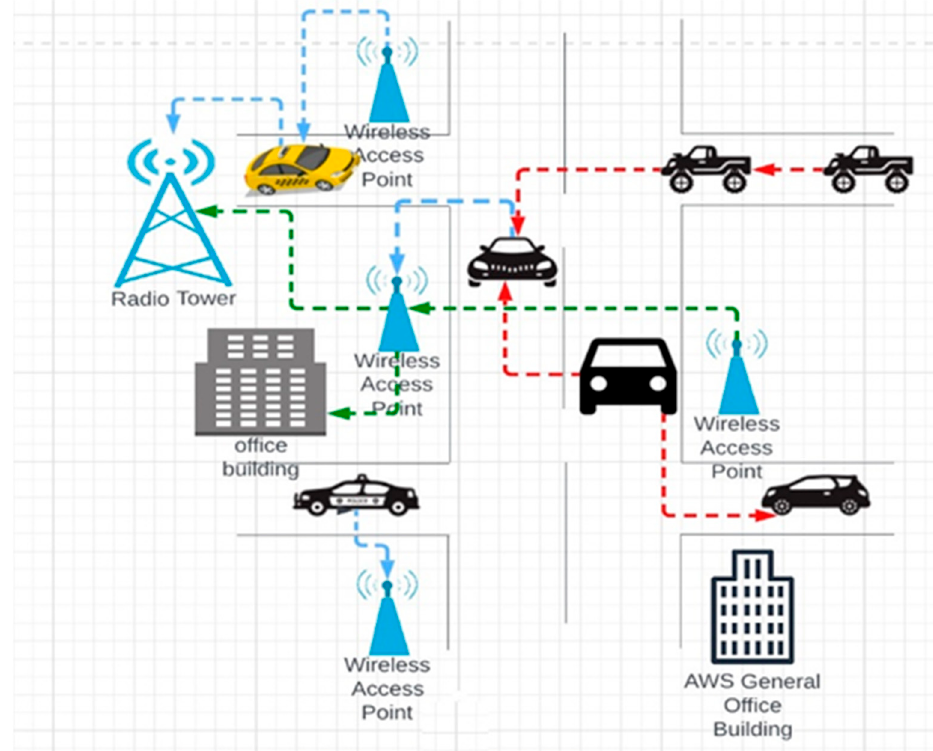
Figure 4. VANET architecture [17].